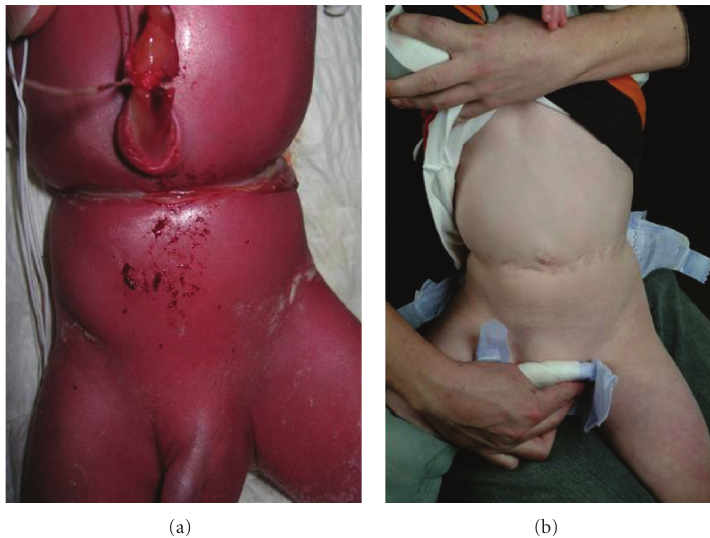
Figure 1: Appearance of the abdomen at birth (a) and at 2 years of age after surgical correction (b). Table 1: Reported cases of congenital constriction band of the abdomen.